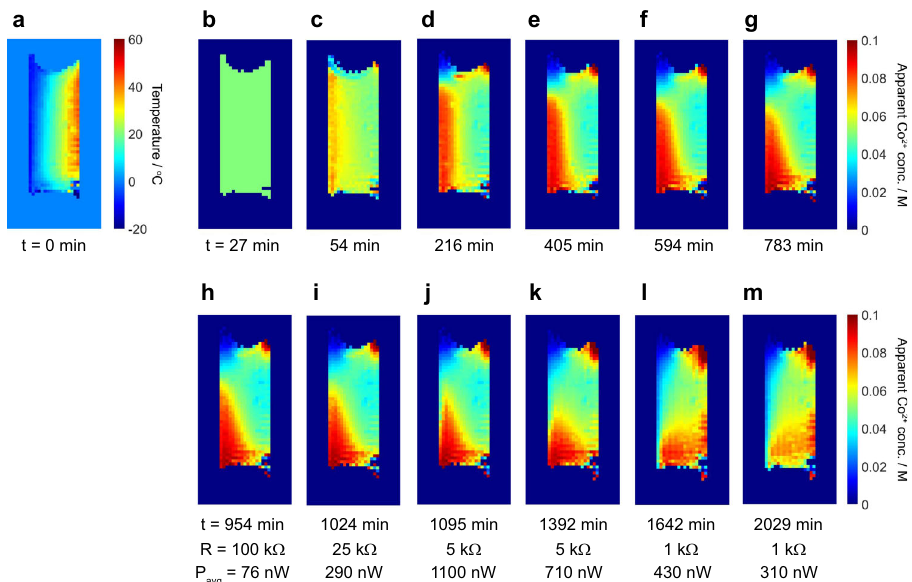
Fig. 4 Imaging competing mass transfer effects in the vertical electrode cell. a Temperature map and b – m apparent Co 2 + concentration maps obtained from the vertical electrode cell with the MPN with 0.05 M Co 2 + /3 + (bpy) 3 (TFSI) 2/3 gel electrolyte at times t indicated. Images a – g were obtained from an unconnected (open circuit) cell. Images h – m were obtained after connecting the load resistances R as indicated. Average powers P avg drawn from the cell during the acquisition of each image are also shown. The uncertainty in concentration for each pixel in these and subsequent images is ±0.008 M. Plots of cell current and voltage versus time for these experiments are provided in Supplementary Fig.